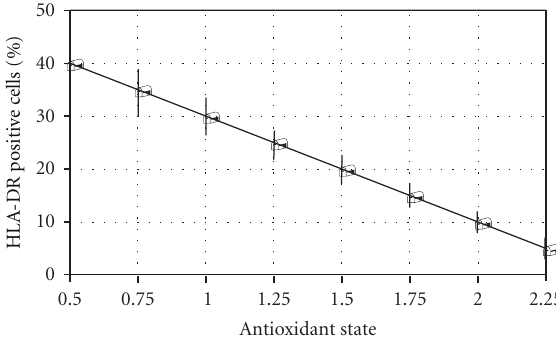
Figure 2: Study of connection between antioxidant status and expression of HLA-DR positive cells. Bars show the ± SD, r = − 0 . 72.